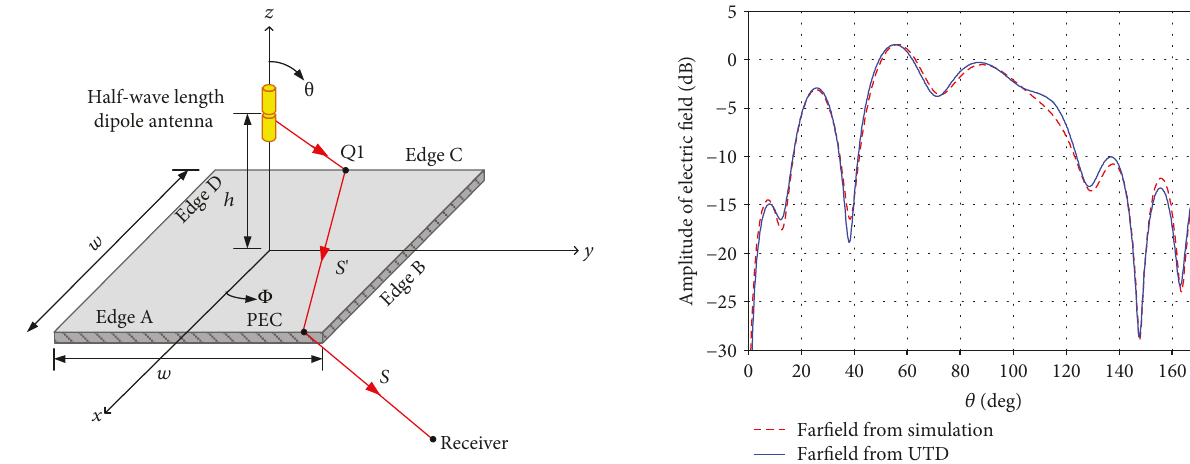
Figure 6: Amplitude of electric fi eld of the θ component in the ϕ =20 ° plane with w =4 λ and h =1 λ , at 4GHz compared with simulation result.